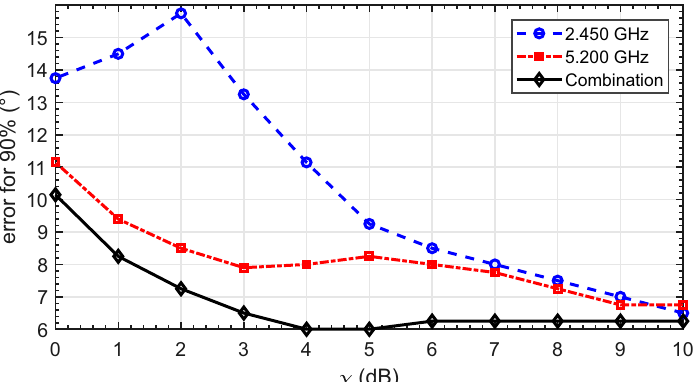
Figure 13. 90-th percentile DoA estimation error for D = 2.5m.